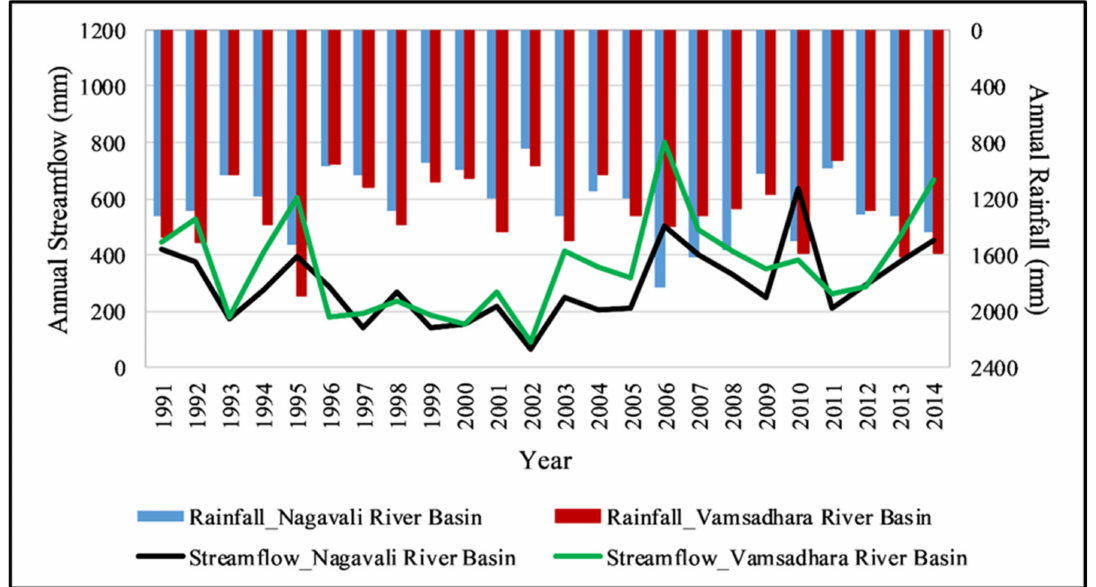
Figure 3. Annual rainfall and streamflow in the Nagavali and Vamsadhara river